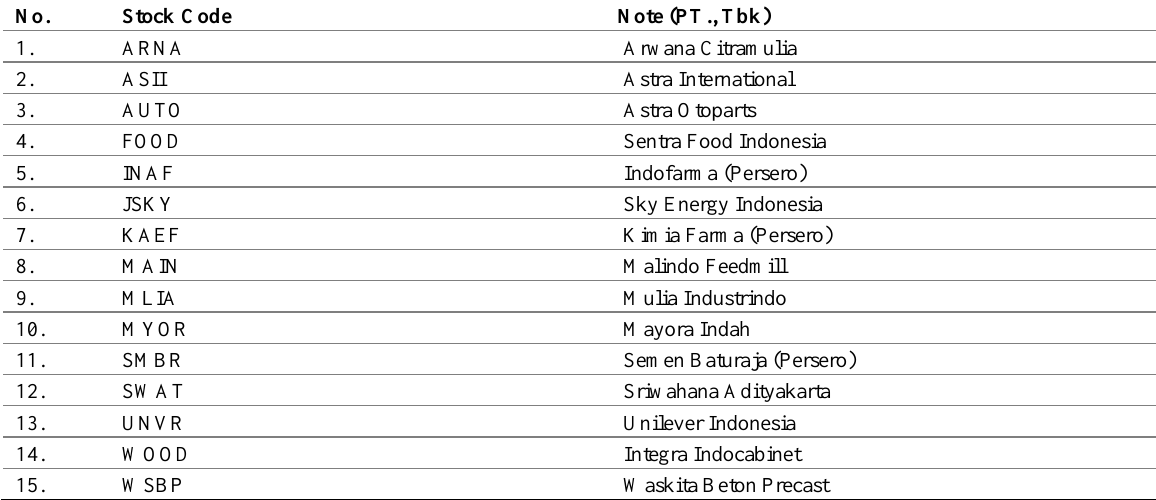
Table 8: List of Manufacturing Entities Included in Optimal